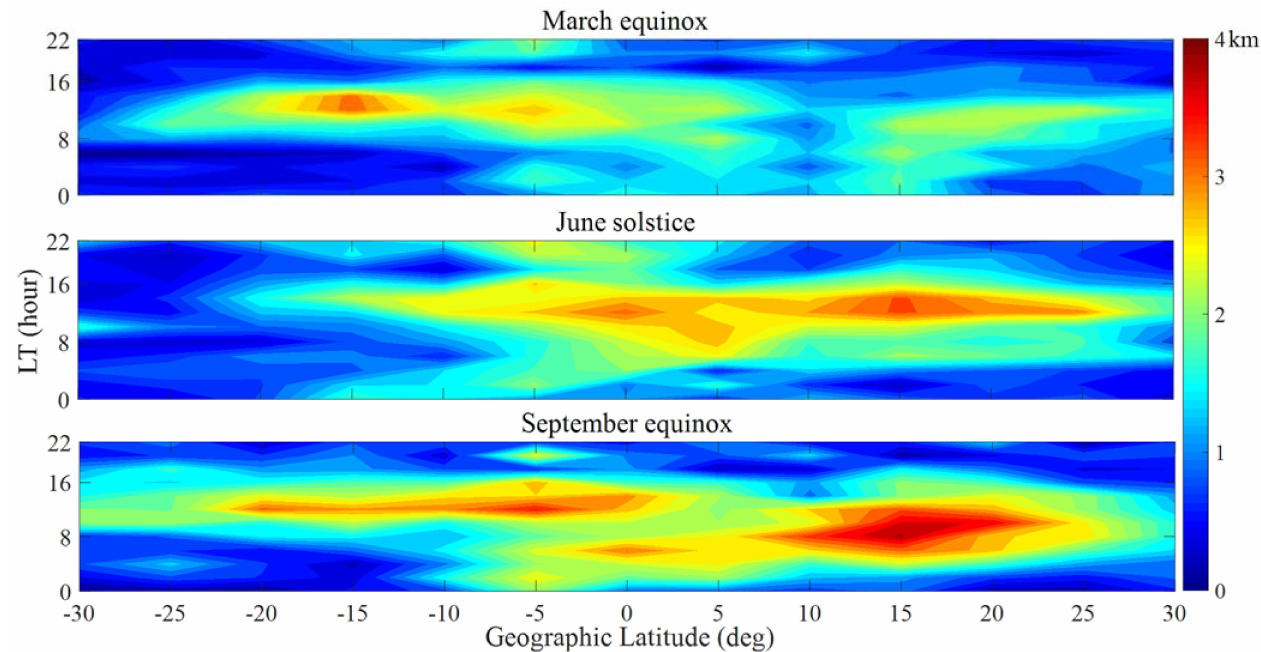
Figure 7. LT-Lat variations of amplitudes derived from the FT for the WN4 component at the March equinox ( the top row ), June solstice ( the middle row ), and September equinox ( the bottom row